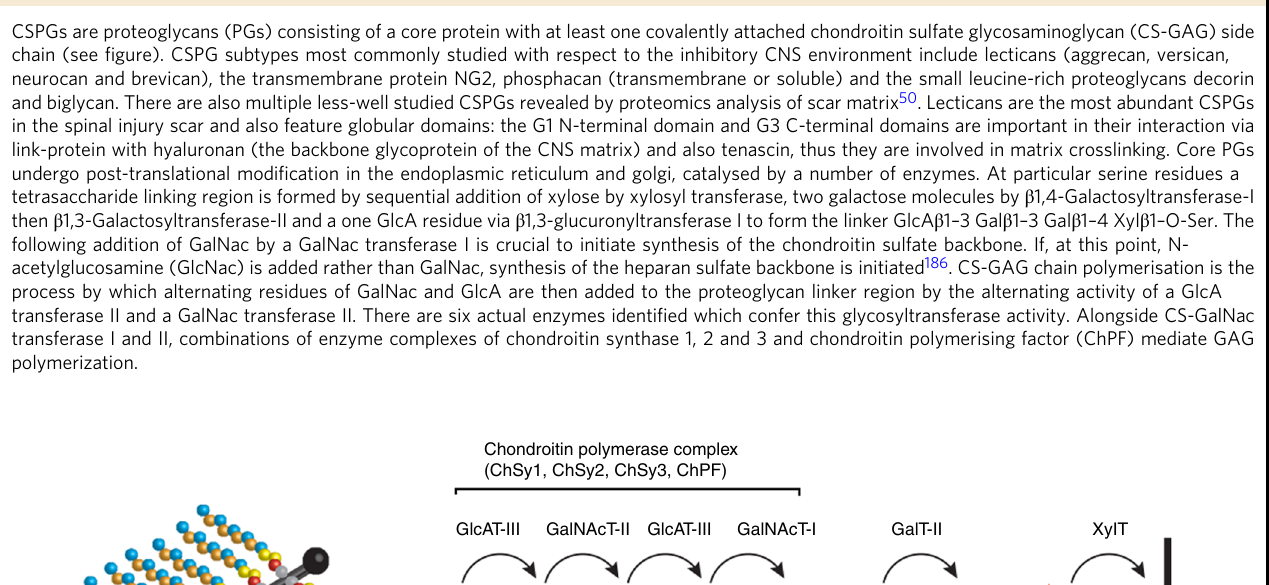
Box 2 | Structure of chondroitin sulfate proteoglycans